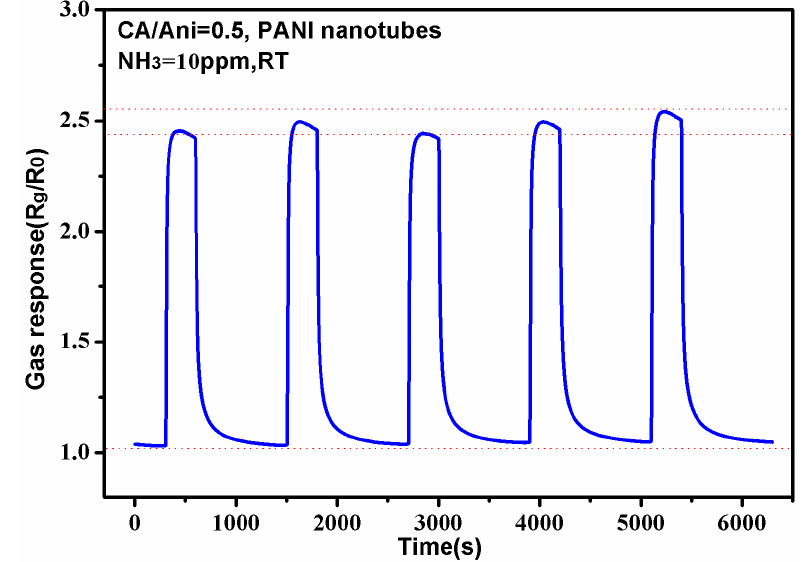
Figure 10. Sensing response of the nanotubes sensor to ammonia of 10 ppm at room temperature.